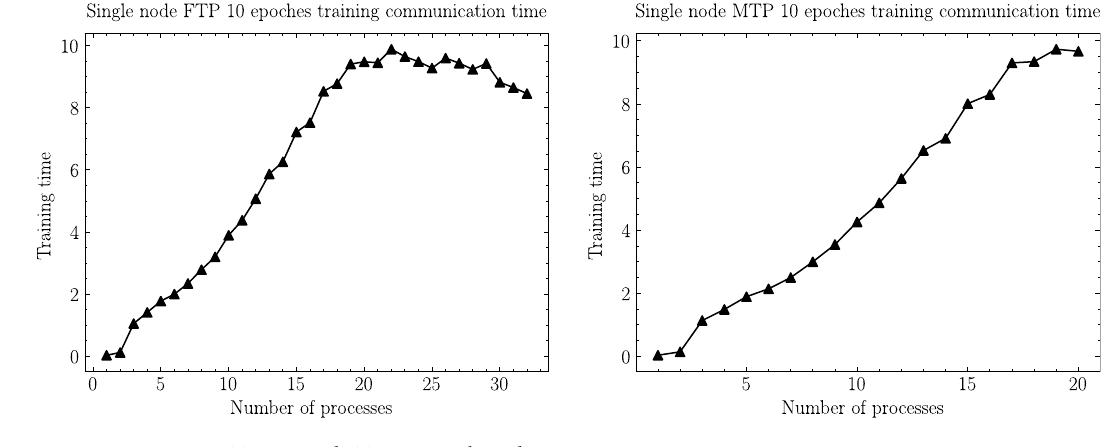
Figure 11. MT2000+ and FT2000+ single node communication